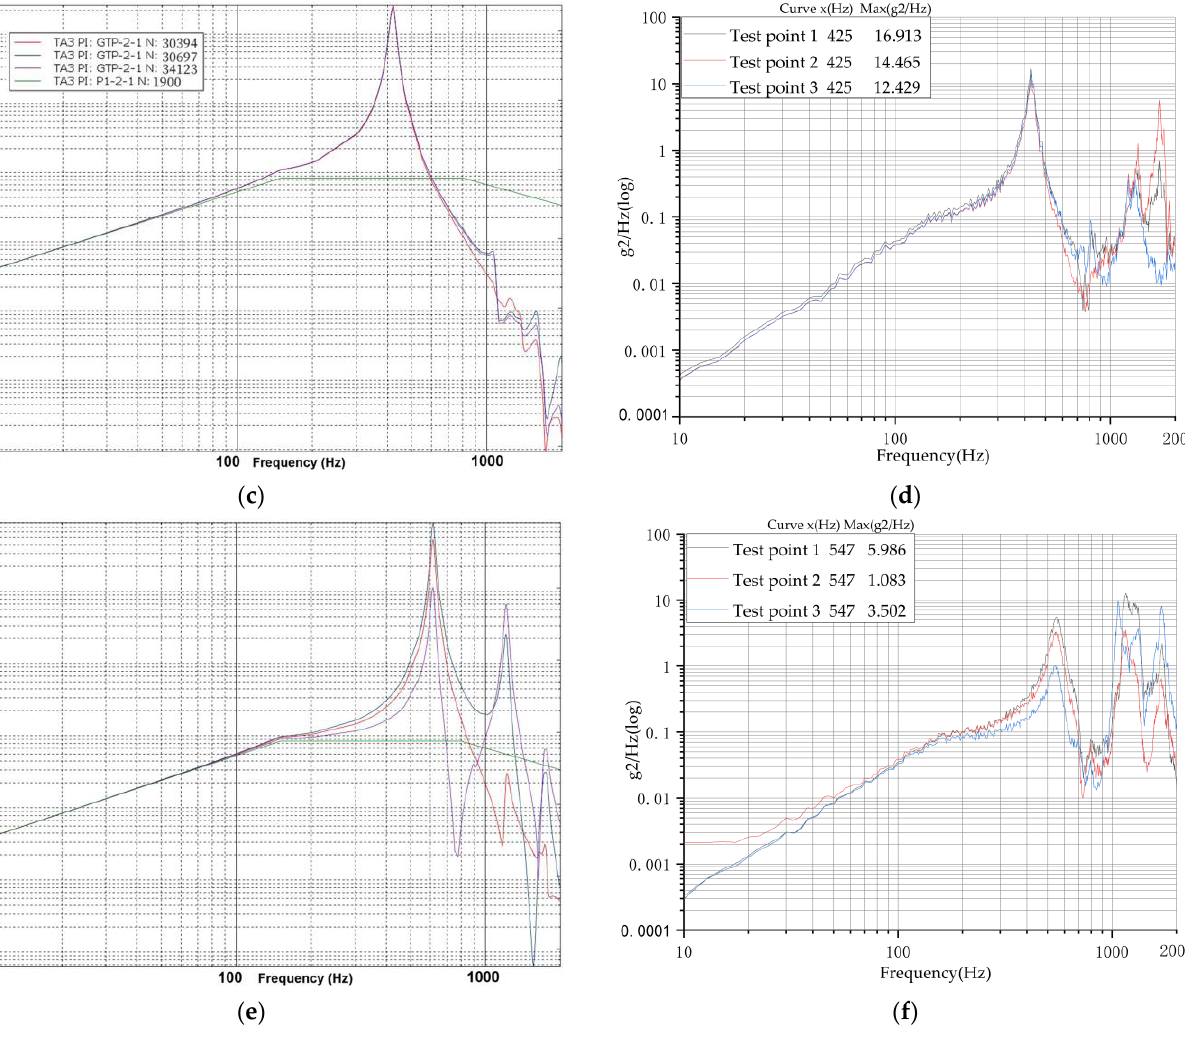
Figure 12. Comparison of theoretical analysis and experimental test PSD response curves: ( a ) X-directional PSD response curve of theoretical analysis. ( b ) X-directional PSD response curve of experimental test. ( c ) Y-directional PSD response curve of theoretical analysis. ( d ) Y-directional PSD response curve of experimental test. ( e ) Z-directional PSD response curve of theoretical analysis. ( f ) Z-directional PSD response curve of experimental test.